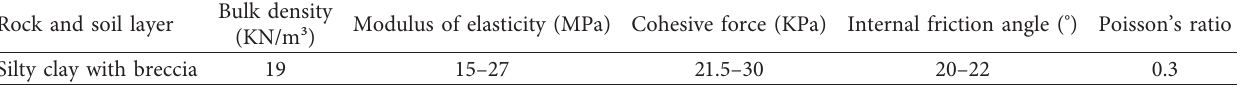
Table 2: Parameters of silty clay with breccia.